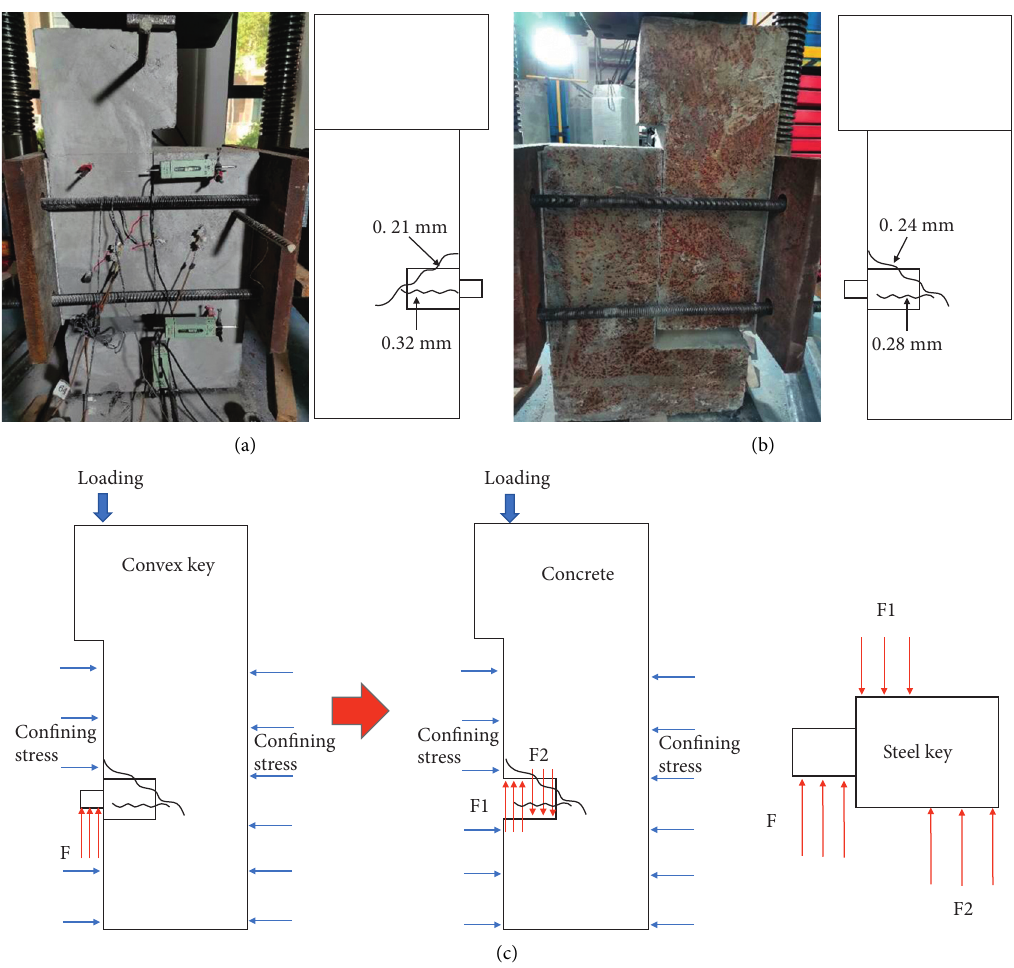
Figure 8: Initial crack of DS2. (a) Section A, (b) section B, and (c) mechanical equilibrium model.